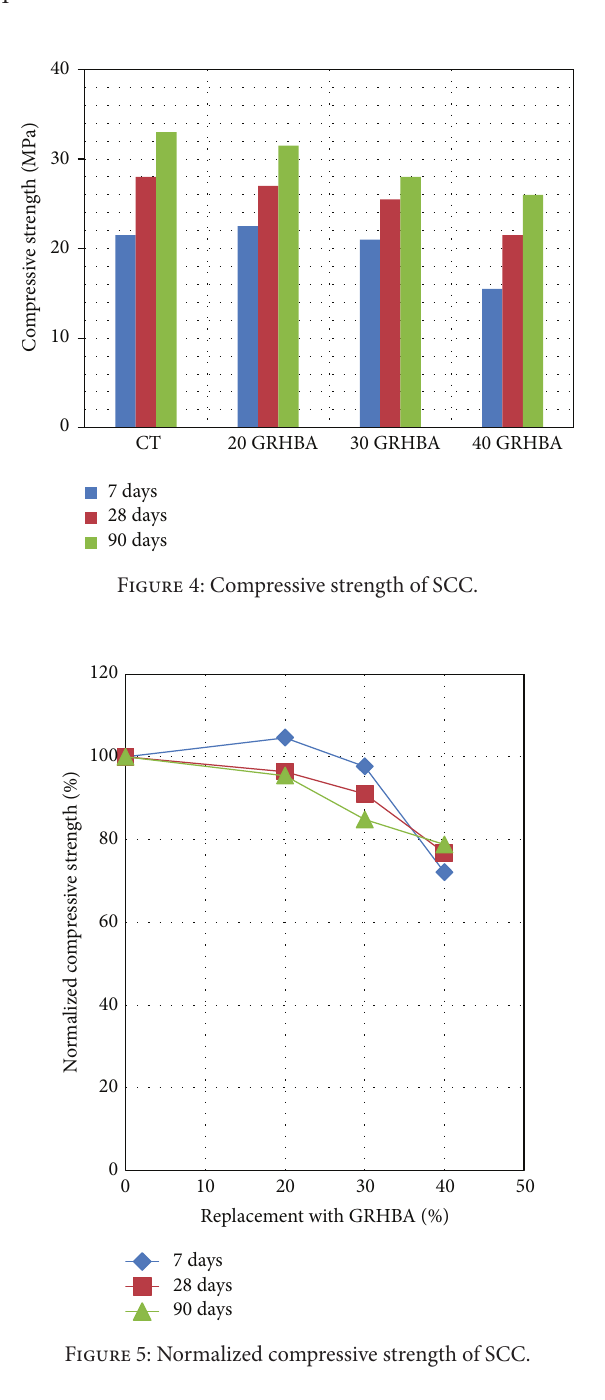
Figure 7: Porosity of